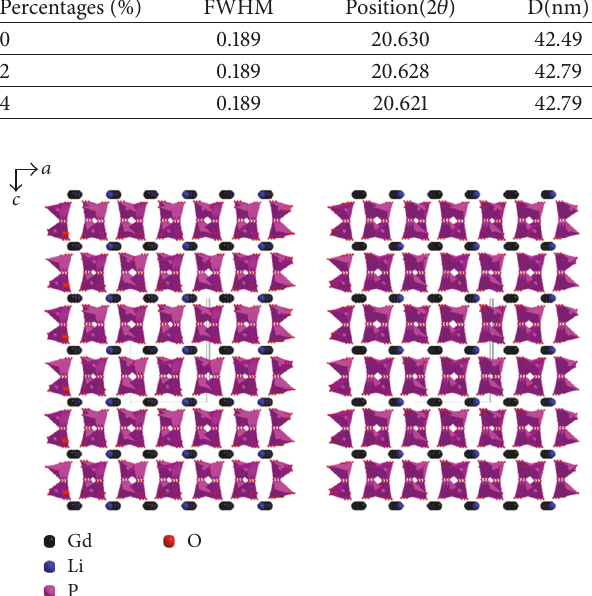
Figure 2: The structural arrangement of the LiGd(PO 3 ) 4 viewed in the (0 1 0) plane.